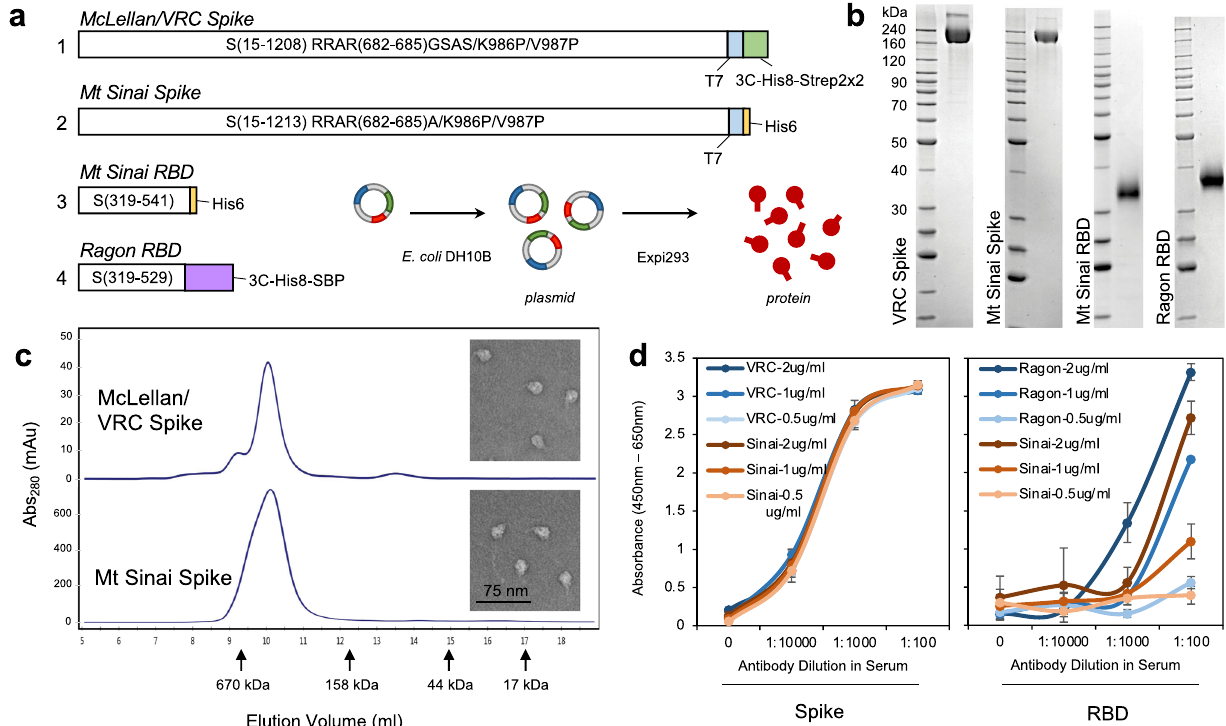
Fig. 2 Production and sensitivity of two full spike ectodomain (Spike) and two receptor-binding domain (RBD) constructs used as antigens in ELISA. a Schematic of the spike and RBD constructs used to generate recombinant proteins. Abbreviations are 3 C, rhinovirus 3 C protease cleavage site; Strep2x2 dual Strep2 epitope tag, T7 bacteriophage T7 fi britin trimerization domain, SBP streptavidin-binding peptide. b SDS-PAGE Coomassie Blue staining of puri fi ed (1) McLellan/VRC spike, n = 27, (2) Mt Sinai spike, n = 6, (3) Mt Sinai RBD, n = 5, and (4) Ragon RBD, n = 13, proteins. c Analytical size-exclusion chromatography of puri fi ed McLellan/VRC ( n = 27) and Mt Sinai spike ( n = 6) proteins. Peak elution volumes of sizing standards are noted (670 kDa — thyroglobulin, 158 kDa — gamma-globulin, 44 kDa — ovalbumin, 17 kDa — myoglobin). Inset: transmission electron microscopy of McLellan/VRC and Mt Sinai spike trimers. Ladder unit = kDa. d Left: full spike ectodomain at three different concentrations of protein coating density for both McLellan/VRC (NIAID Vaccine Research Center, blue) and Sinai (Mount Sinai, orange) constructs. Right: RBD constructs at three different concentrations of protein coating for both Ragon (Ragon Institute, blue) and Sinai (Mount Sinai, orange) constructs. Anti-spike or anti-RBD monoclonal recombinant antibody spiked into negative serum at 1:100, 1:1000, and 1:10000 dilution. Data are means ± SD, n = 4 independent study replicates on two independent protein preparations. Source data are provided as a Source Data fi